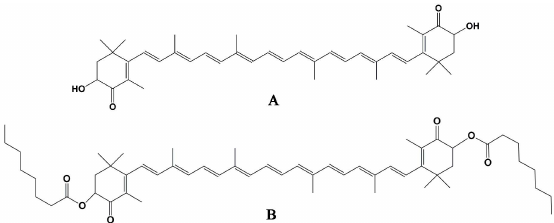
Figure 1. Structures of AST and AOD (according to Fukami et al. [15]). ( A ) AST: free astaxanthin. ( B ) AOD: astaxanthin n -octanoic acid